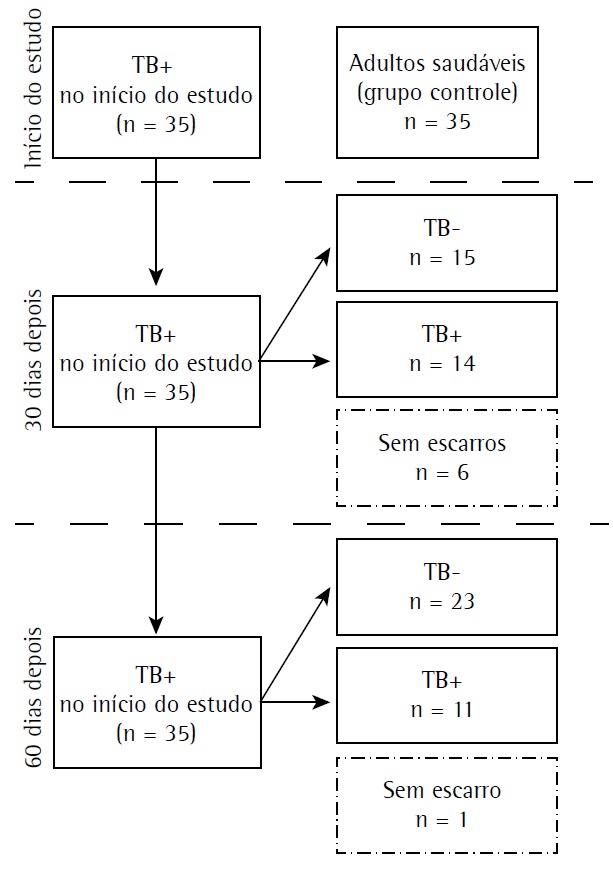
 Grupo controle e grupo de estudo no início do estudo, 30 dias após o
início do tratamento da tuberculose e 60 dias após o início do tratamento da
tuberculose. TB+: cultura de escarro positiva ou baciloscopia de escarro
positiva naquele momento do estudo; e TB−: cultura de escarro negativa e
baciloscopia de escarro negativa naquele momento do estudo.